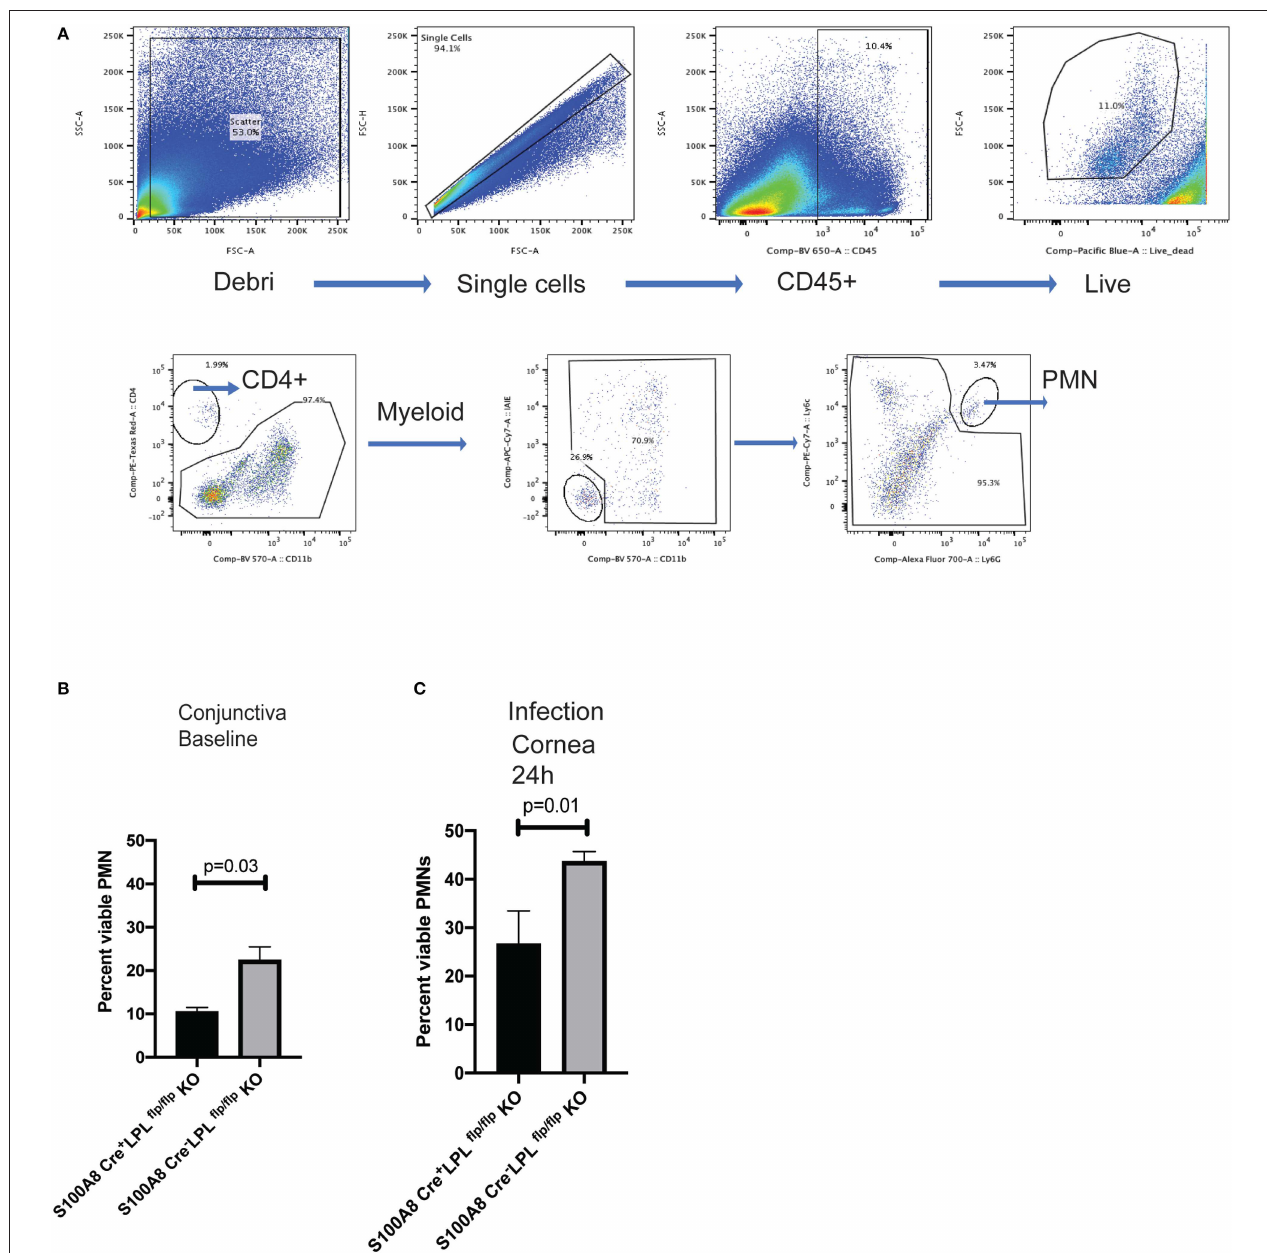
FIGURE 6 | S100A8.Cre pos mice show diminished frequencies of viable PMNs at baseline and during infection. Gating strategy for analysis of the conjunctival tissues harvested from naïve S100A8.Cre pos and S100A8.Cre neg mice. Neutrophils were identified as CD45 + , viable, Ly6G + cells. Flow cytometry analysis using CD45, CD11b, Ly6G was carried out on pooled conjunctival and corneal tissues from non-infected LPL KO and WT littermates. (A) Percent CD45 + , viable, Ly6G + cells in the conjunctival tissues. At least 5 mice per genotype were harvested and analyzed individually. Experiments were performed twice with similar outcomes (Student’s t -test, p = 0.03). (B) Percent CD45 + , viable, Ly6G + cells in the infected corneas. Mice were infected with 5 × 10 5 CFU P. aeruginosa 6294 per eye and corneal tissues harvested at 24h post-challenge. At least 5 mice per genotype were analyzed individually. Experiments were performed twice with similar outcomes